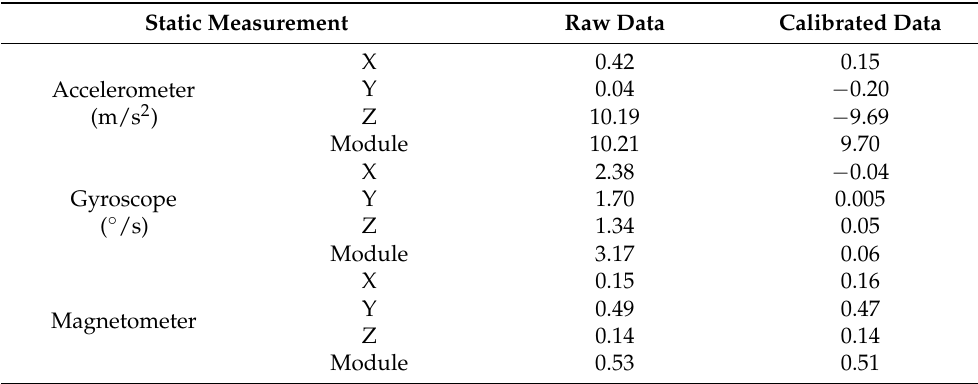
Table 1. Data comparison table before and after sensor